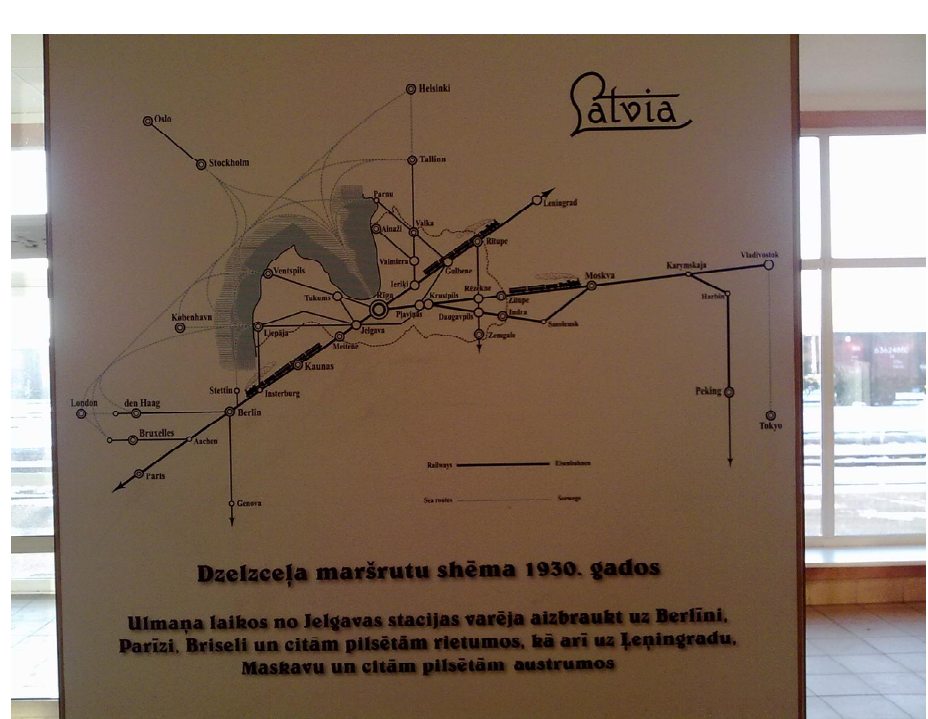
Figure 1 Former Rail Baltica Plan in Global Context (picture taken in railway station of Jelgava, Latvia, by Dr. Saranen during Feb.